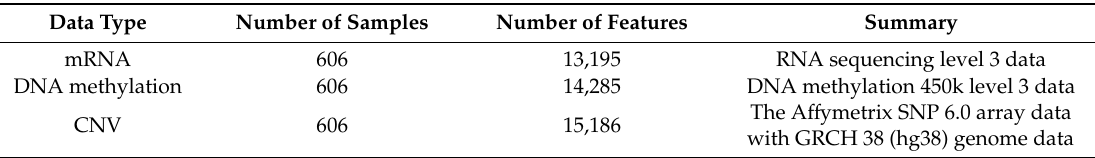
Table 2. The summary of breast cancer